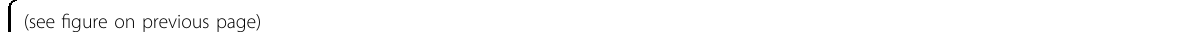
Fig. 7 17 β -Estrogen decreases RANKL-induced PRMT1 expression in BMDMs. a , b BMDMs were pre-treated with or without E2 (1 μ M) for 2 h and then treated with RANKL (100 ng/ml) for 24 h. a PRMT1 protein expression was examined via western blotting. b The level of PRMT1 mRNA was measured via real-time PCR and was then normalized to the β -actin level. c , d BMDMs were pre-treated with E2 (1 μ M) with or without pre-treatment by ICI 182,780 (10 μ M). After 2 h, the cells were treated with RANKL (100ng/ml) for 24 h. The proteins were extracted and subjected to western blot analysis with PRMT1 and β -actin antibodies. The data are presented as the mean ± SD. * p < 0.05, ** p < 0.01, *** p < 0.001. e Schematic showing the mechanism of PRMT1 during